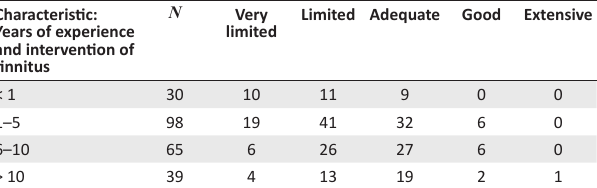
TABLE 5: Years of experience and intervention of tinnitus. Characteristic: Years of experience and intervention